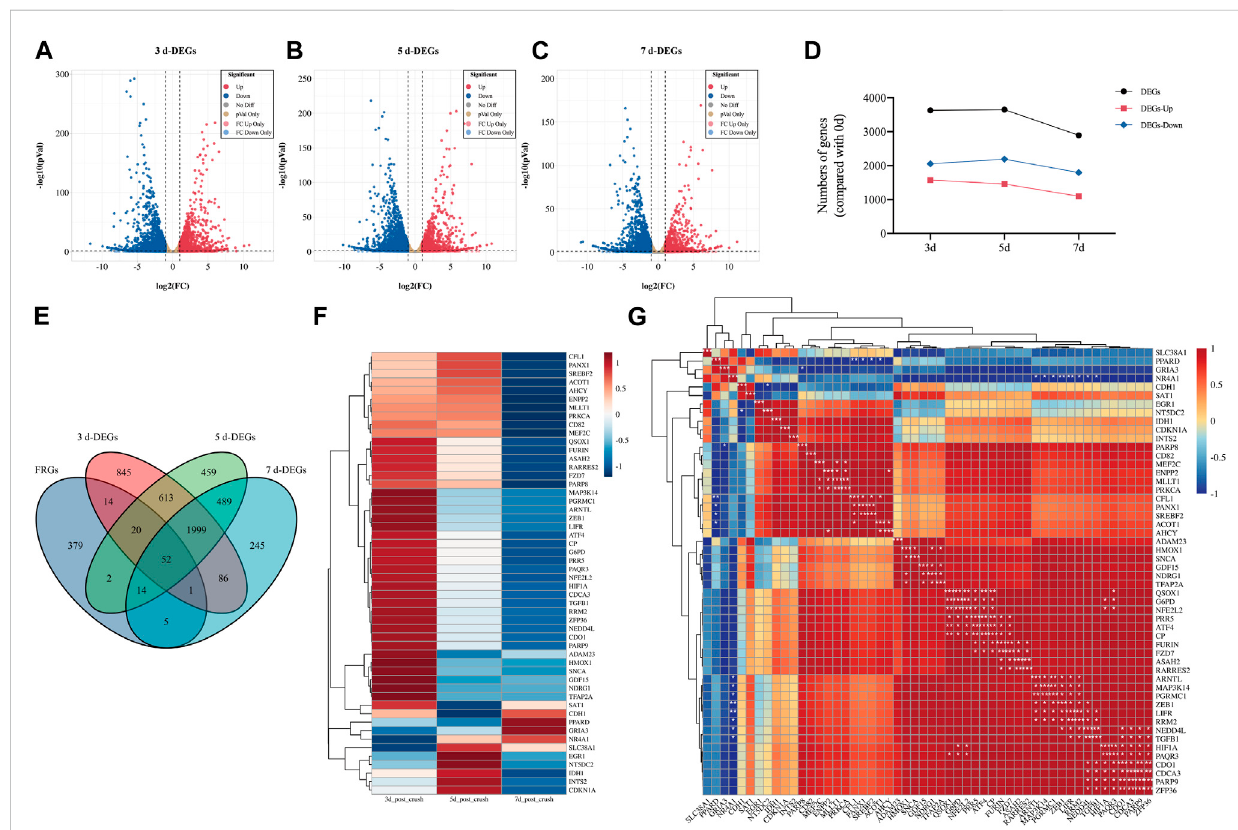
FIGURE 1 Identi fi cation of DE-FRGs in sciatic nerve after crush injury. (A – C) Volcano plots of differentially expressed genes (DEGs) of 3-day group, 5-day group, and 7-day group after sciatic nerve injury compared to 0-day group (uninjured, control). Data was obtained from GSE177037. Red dots represent signi fi cantlyupregulatedgenesandbluedotsrepresentsigni fi cantlydownregulatedgeneswithanadjusted p -value < 0.05and|log2FC| > 1. (D) Alinechart of the number of genes of DEGs, upregulated DEGs and downregulated DEGs over time. (E) Venn diagram shows the DE-FRGs. (F) The clustering heatmap displays the relative expression extent of 52 DE-FRGs at 3-day group, 5-day group, and 7-day group post crush injury compared to 0-day group. The level of expression increases with increasing redness and decreases with increasing blueness. The clustering results are shown on the left of theimage. (G) The clustering correlation heatmap represents signi fi cant correlationsamong 52 DE-FRGs. The clustering results areshown attheleft and top of the image. The color bars indicate the degree of correlation between genes. A darker red indicates a more positive correlation, while a darker blue indicates a more negative correlation. * indicates signi fi cance level, * p < 0.05, ** p < 0.01, *** p <